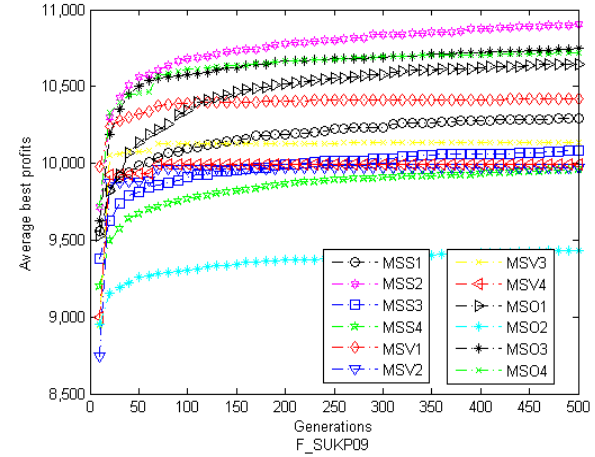
Figure 7. The convergence graph of twelve discrete MS algorithms on F09.